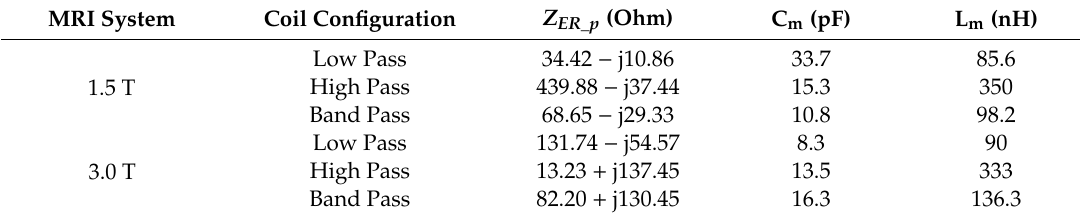
Table 4. Input impedance Z ER_p of the designed birdcage RF coils at dominant resonance frequency and the corresponding lumped components of the matching circuit for 1.5 T and 3T MRI systems.